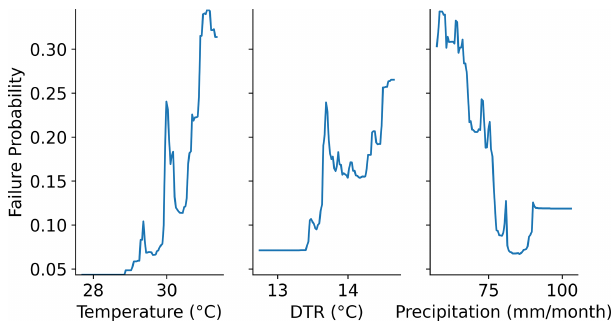
Figure 4. Partial dependence plots showing the failure probabil- ity (0 to 1.0) given the variation of the meteorological variables, monthly maximum temperature (temperature), diurnal temperature range and monthly precipitation (precipitation) along the months of July and